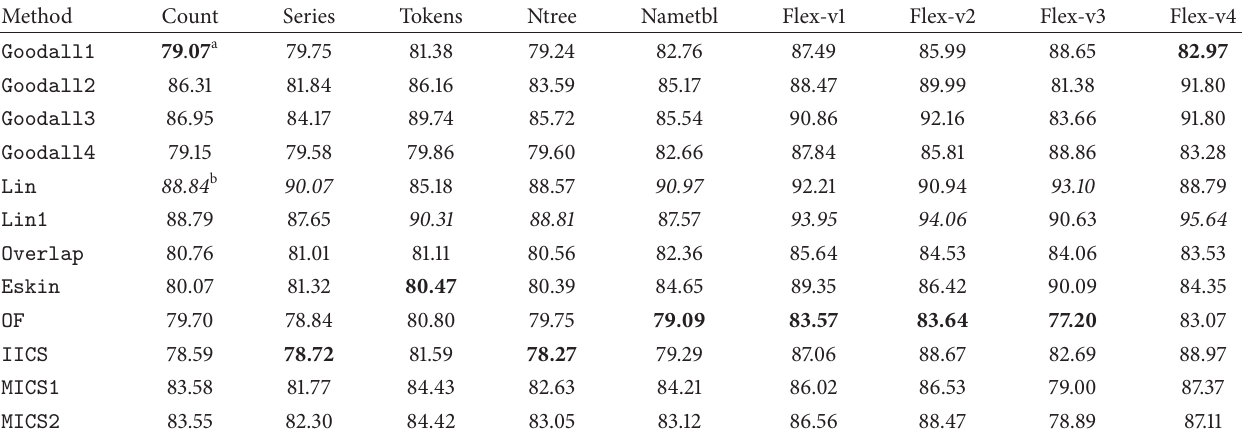
Table 4: The average ART 𝐹 - ratio of each FSCS-CID version for each subject program (%).